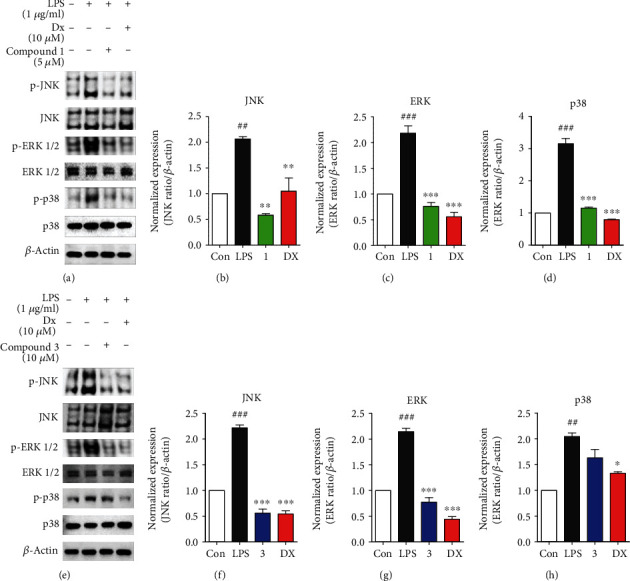
Compounds 1 and 3 suppressed MAPK signaling pathway. (a, e) Immunoblot analysis showed that phosphorylated protein levels of MAPK signaling cascades, JNK, ERK1/2, and p38 are inhibited by compounds 1 (a) and 3 (e) in RAW264.7 macrophages. (b–d, f–h) Total-JNK, ERK1/2, and p38 MAPK proteins were used as loading controls. (b, f) Cells were preincubated for 2 h with each compound 1 and 3 at concentrations of 5 and 10 μM, respectively, and stimulated with LPS (1 μg/mL) for 1 h. Dexamethasone served as the positive control. Immunoblot analysis performed triplicate experiments, and data represented means ± SEM. Significant difference was considered at the levels of ##p < 0.01, ###p < 0.001, ∗p < 0.05, ∗∗p < 0.01, and ∗∗∗p < 0.001 versus LPS.